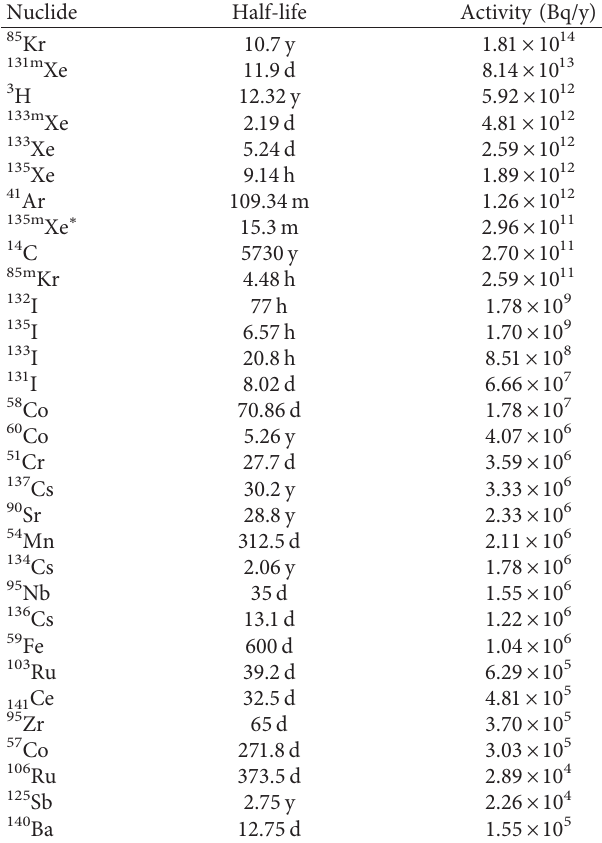
Table 1: Source term for GASPAR